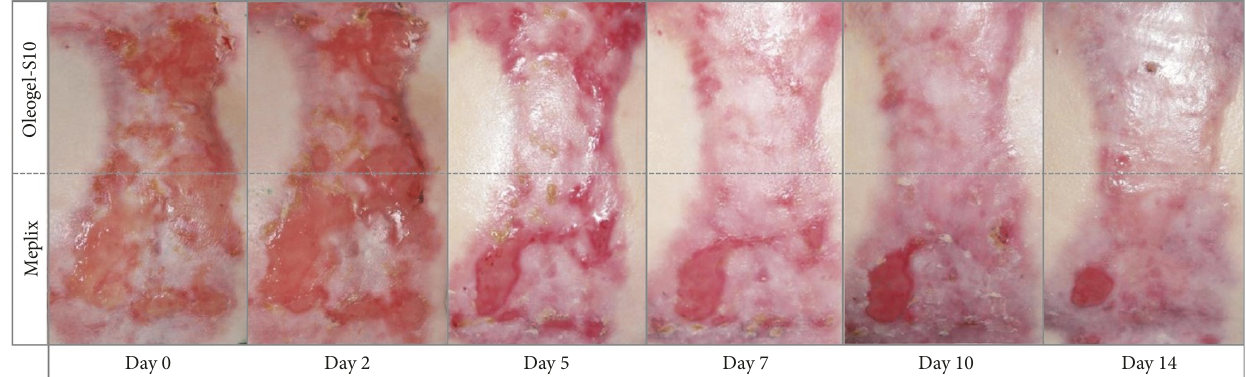
Figure 5: Complete wound closure of the intervention wound at day 13 of